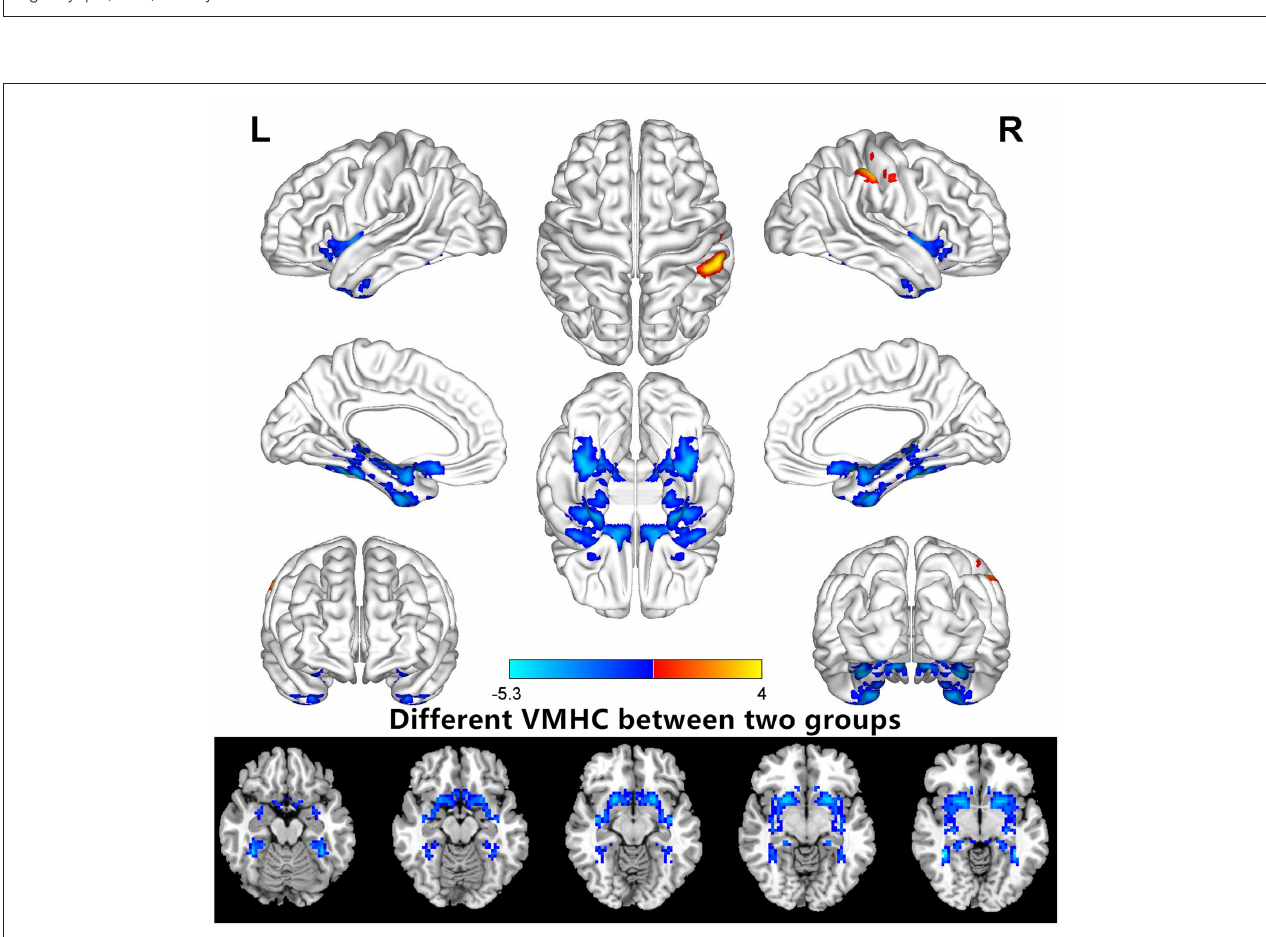
FIGURE 2 | Different VMHCs between the HM and HC groups (voxel level P < 0.01, GRF correction, cluster level P < 0.05). VMHC, voxel-mirrored homotopic connectivity.